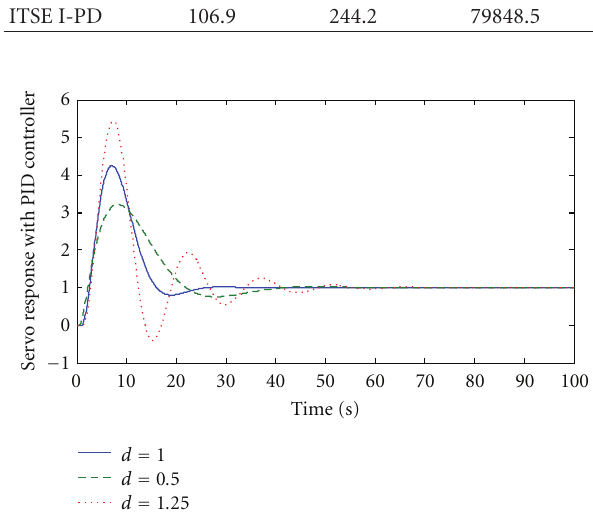
Figure 14: BFO-based PID controller tuning.